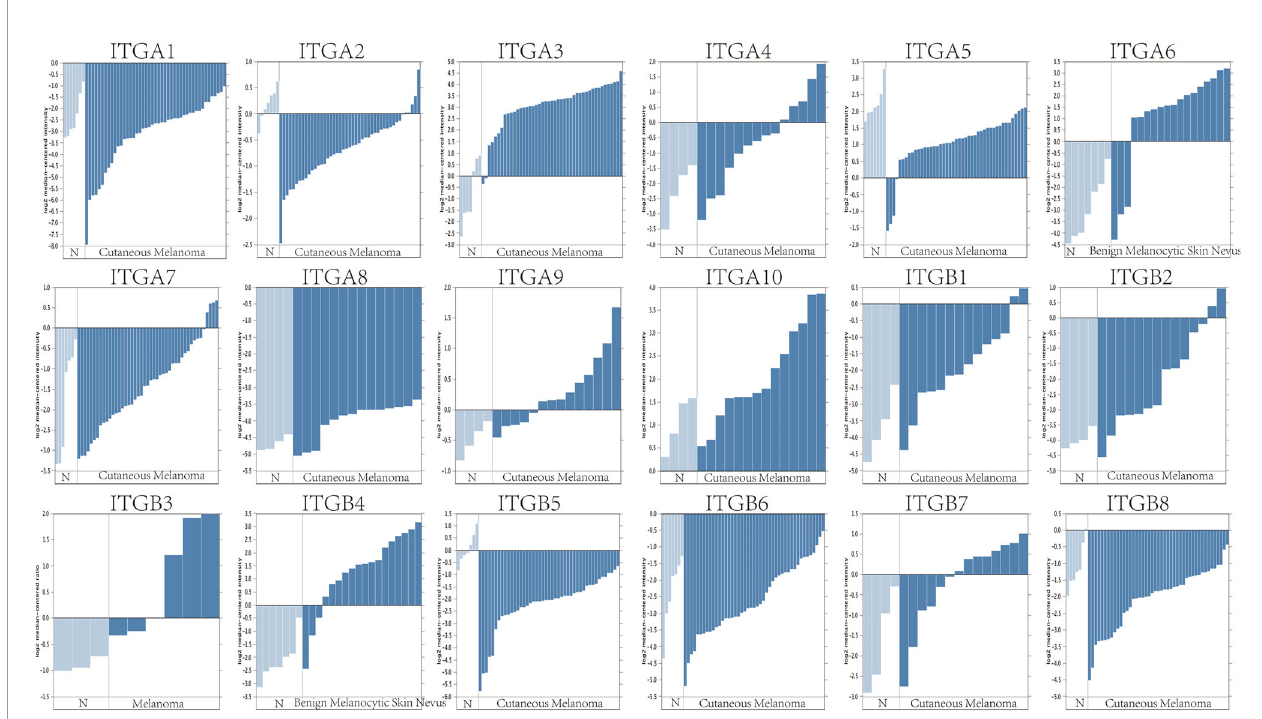
FIGURE 1 | The mRNA expression levels of different integrin subunits in cutaneous melanoma/melanoma/benign melanocytic skin nevus and normal skin tissue (N). The t-test statistic provided in ONCOMINE re fl ects the magnitude of the difference between the groups. Each bar represents the gene expression of one sample. The p value was set at